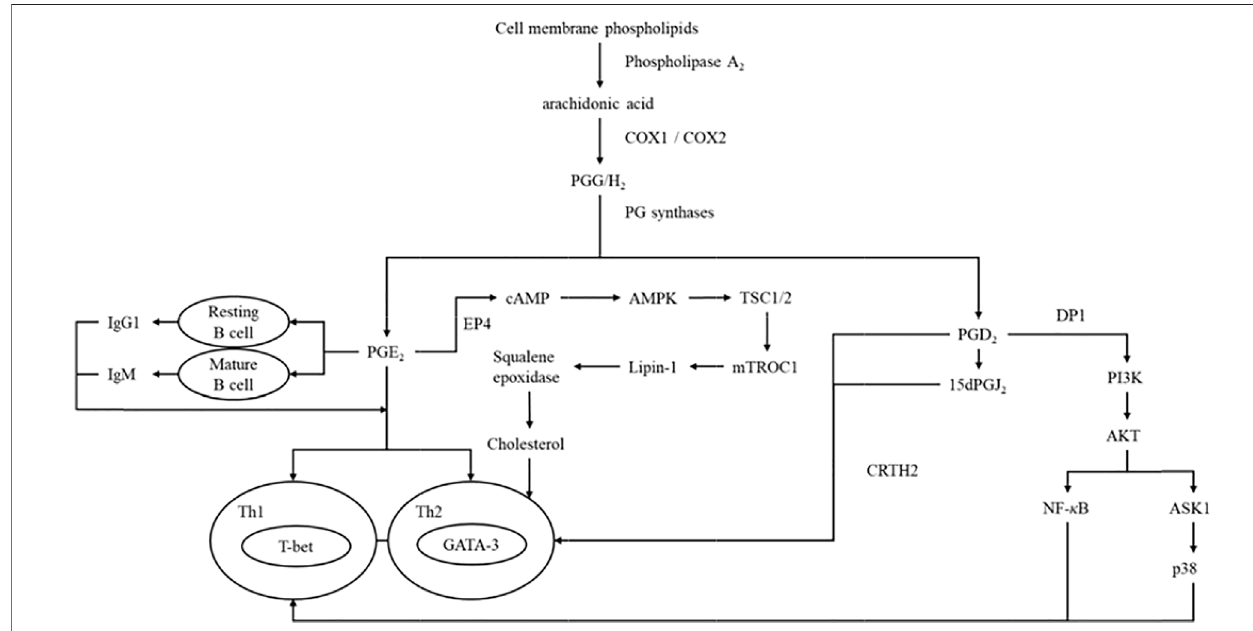
FIGURE 8 | The relationship between Th1/Th2 cell differentiation and arachidonic acid metabolism pathway.